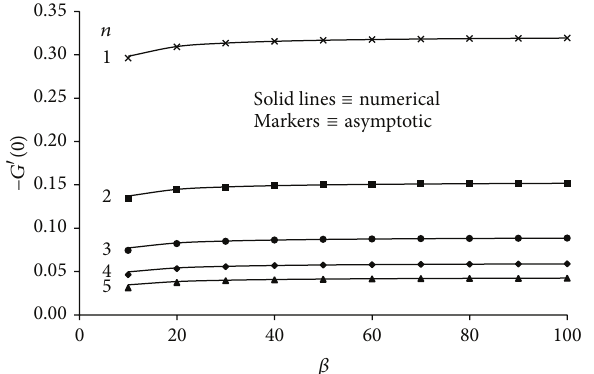
Figure 3: Azimuthal surface traction −𝐺 󸀠 (0) versus 𝛽 , with different values of 𝑚 ; 𝑛 = 1 , 𝑉 𝑠 = 0 .